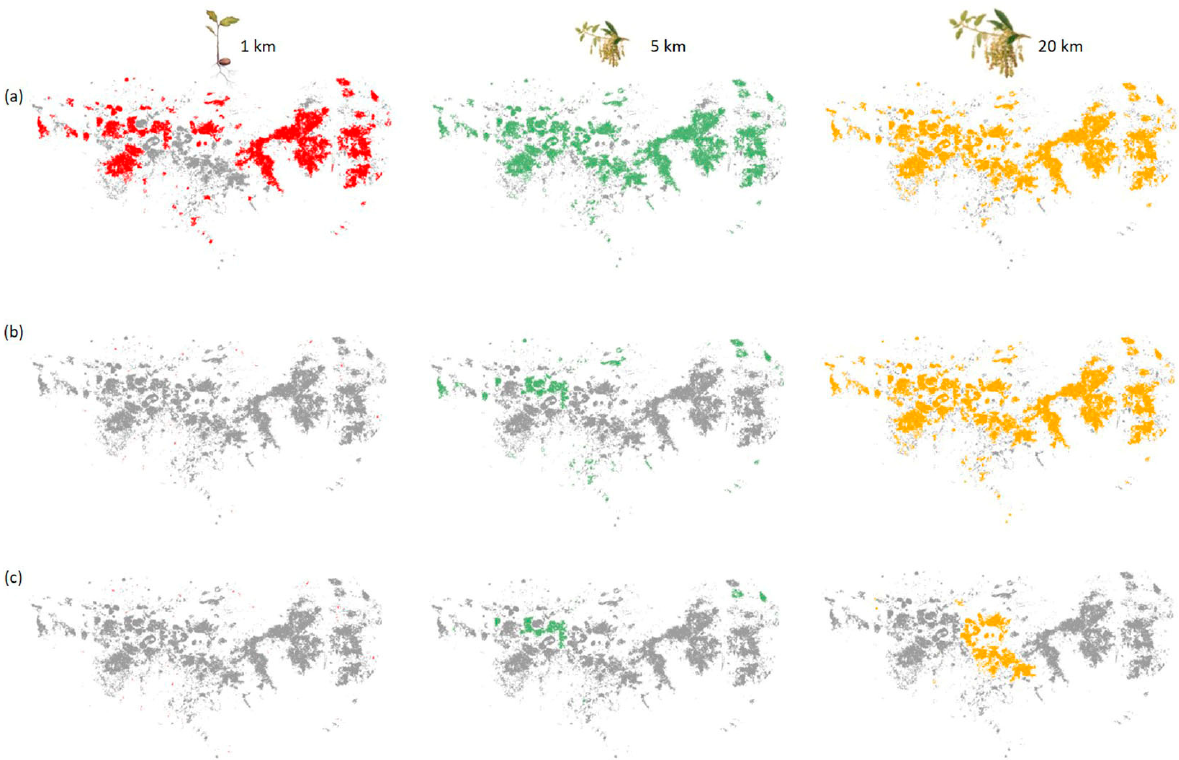
Figure 3. Maps of the temperate forest within the Avocado Belt of Michoacán, Mexico, showing the prioritizing indexes: CCI f ( a ) and ECA f ( b ). Indices are shown for the dispersal distance thresholds of seeds (1 km) and pollen (5 and 20 km), considering the size as the patch attribute. Values of the indices are indicated by the color of the bars.